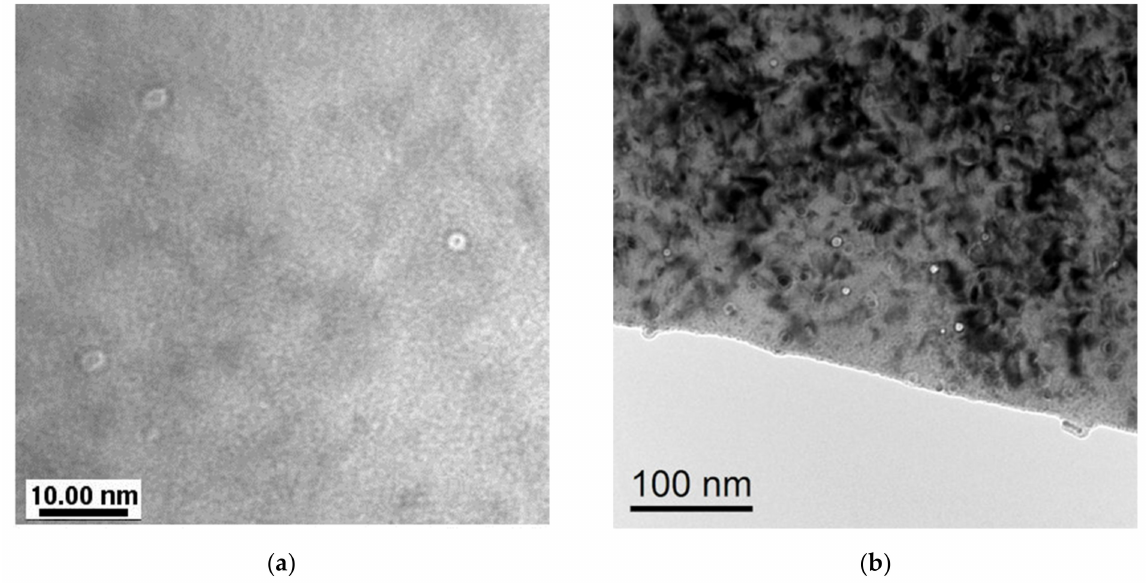
Figure 28. ( a ) BF TEM image of a SA 304 stainless steel from a control rod blade irradiated to 12 dpa; ( b ) BF TEM image of a CW 316 stainless steel from a baffle bolt that was irradiated to 15 dpa. Both examples show sparser, but larger cavities than those observed in the FTT material of this study, despite significantly lower accrued dpa